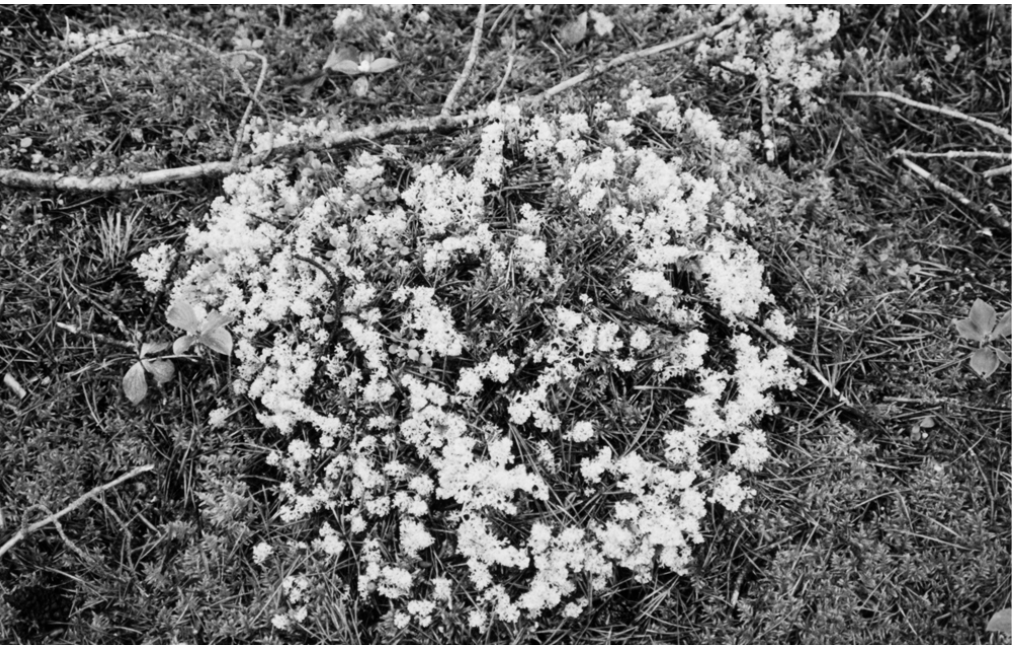
Figure 1. Cladonia mitis mat in late-successional pine forest (130 years old) in the Omineca River water- shed, British Columbia, shows progressive infilling and burial of lichen mat by feather moss fronds. The individual clump shown here is ca. 30 cm in